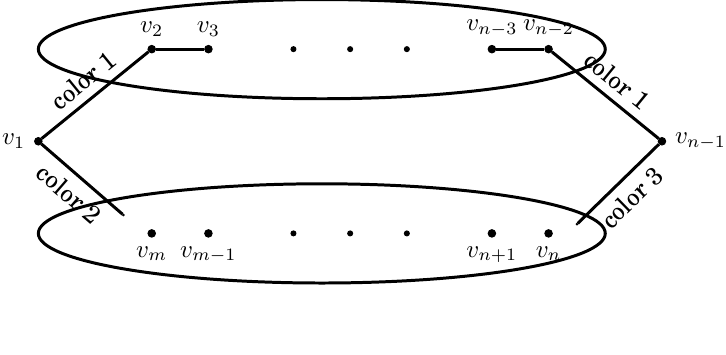
Figure 1: Case 1 of the proof of Theorem 2.10.